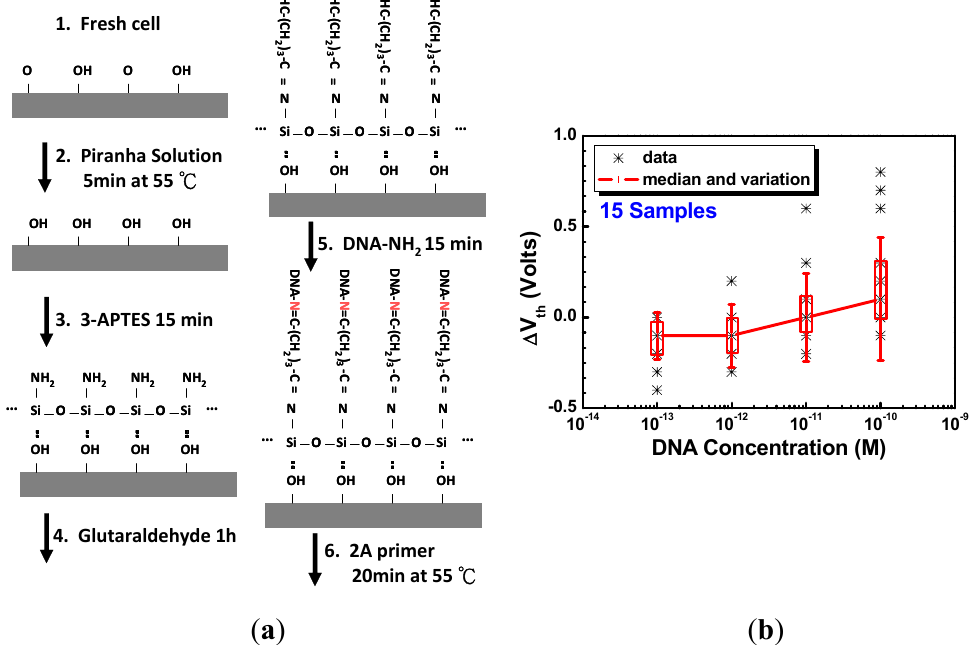
shift of the poly-Si th shift is th